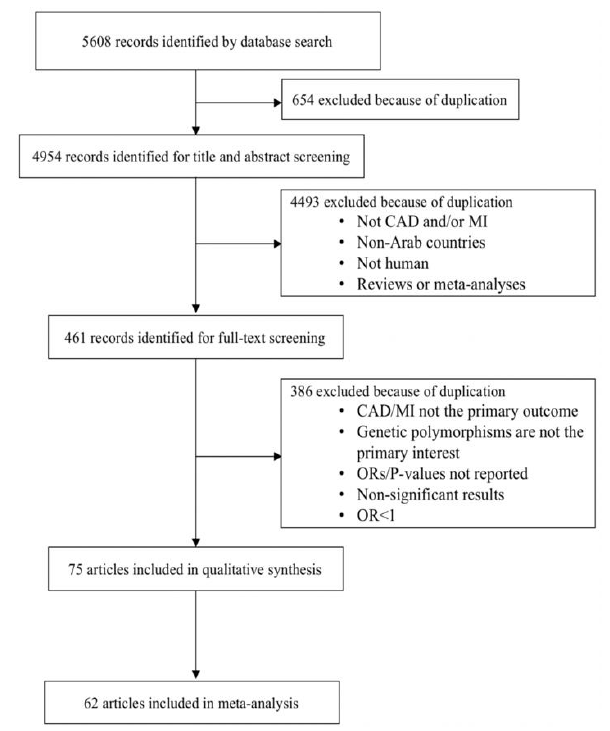
Figure 1. PRISMA flow diagram of the included